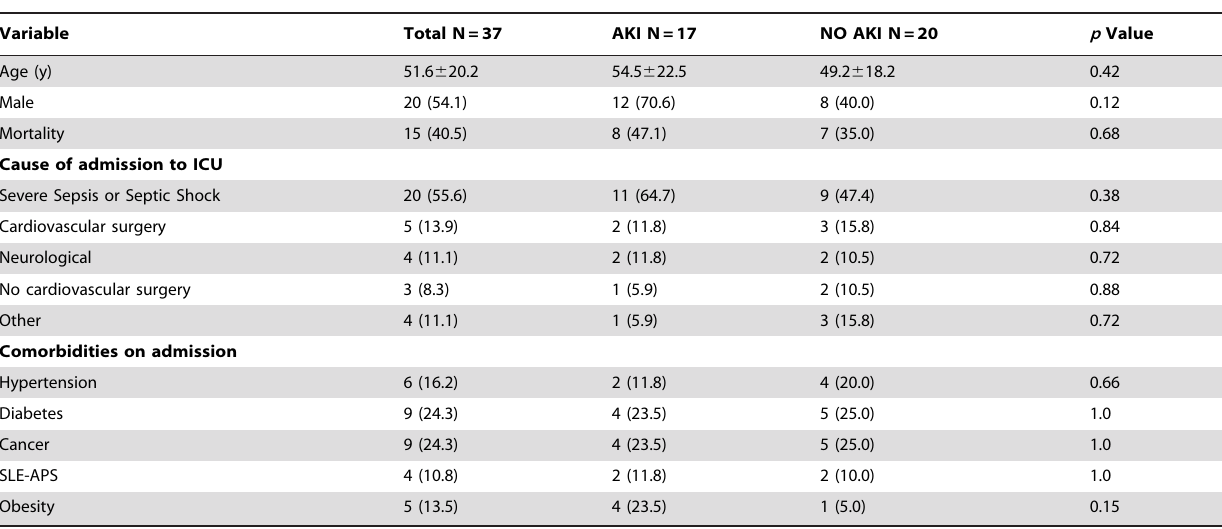
Table 1. Summary of baseline and clinical